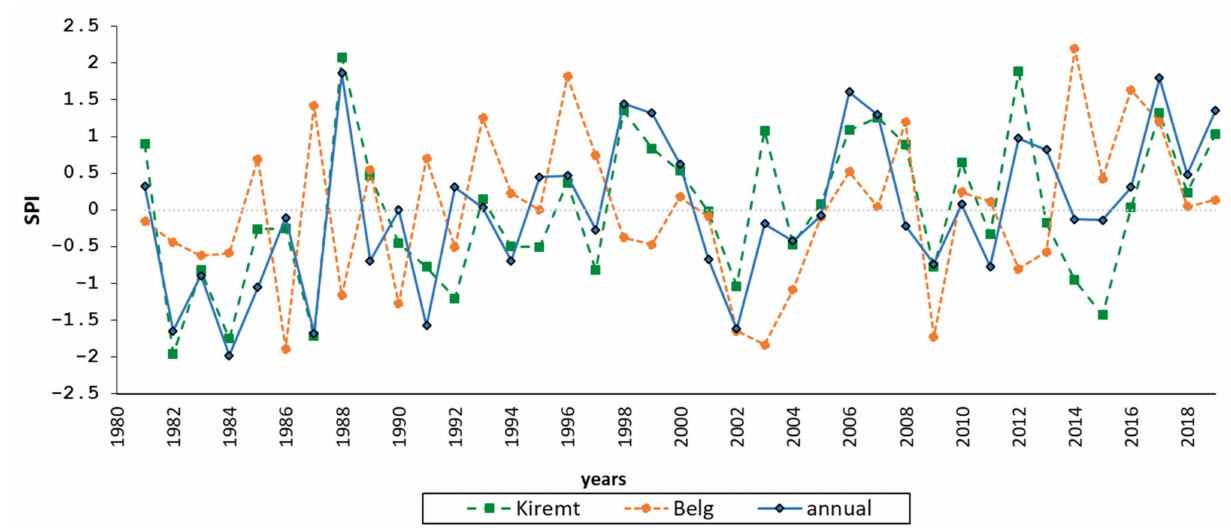
Figure 8. The seasonal SPI during kiremit and belg, and the annual SPI.